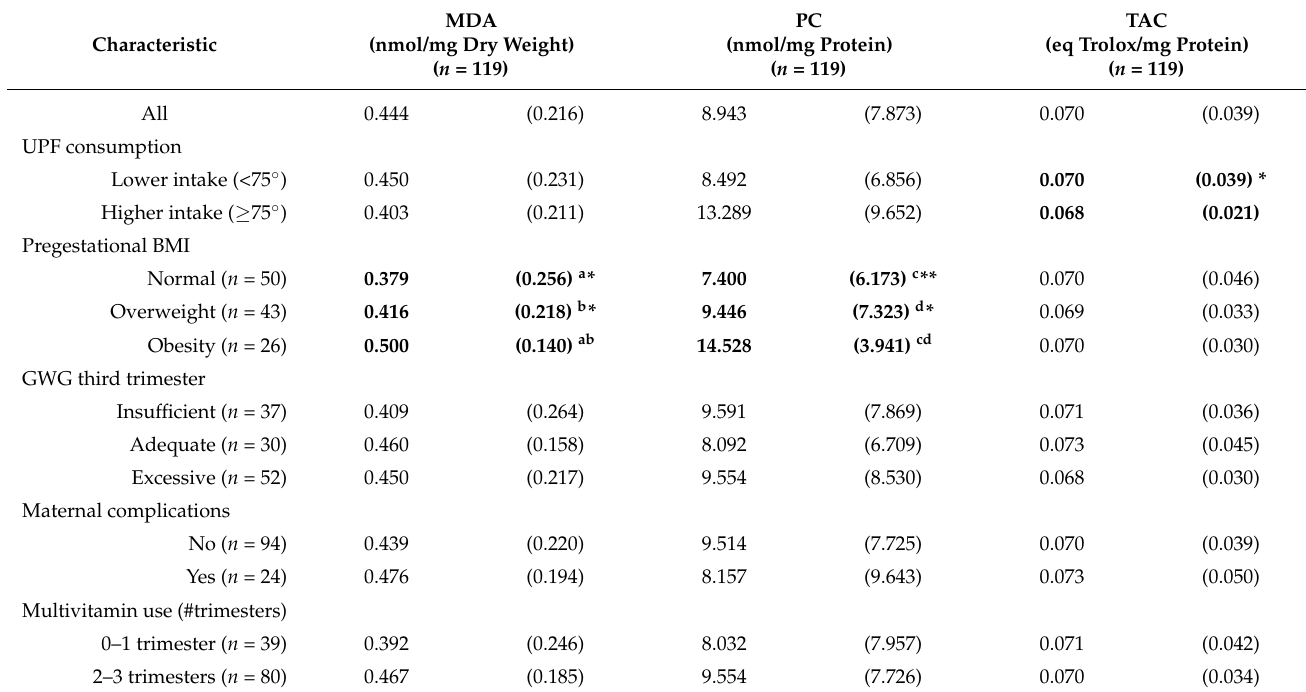
Table 3. Oxidative stress markers according to maternal clinical